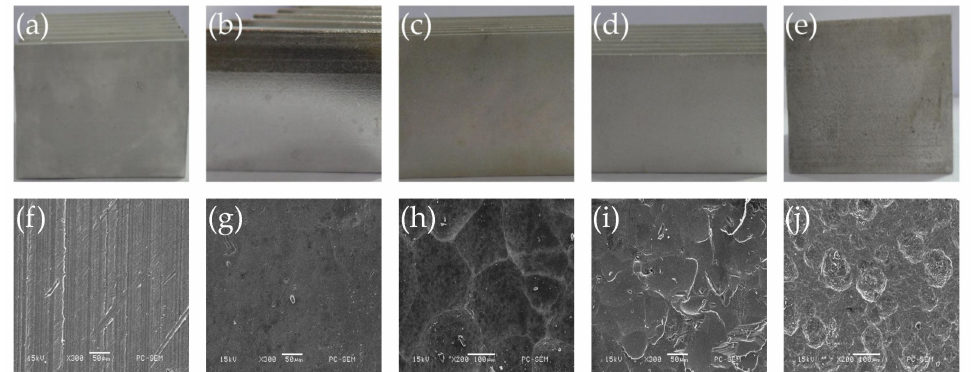
Figure 4. Surfaces of heat sinks with different treatment: photos of heat sinks ( a ) without treatment, ( b ) chemical polishing, ( c ) chemical coarsening, ( d ) mechanical shot peening and ( e ) chemical oxidation; SEM images of heat sinks surfaces ( f ) with- out treatment, ( g ) with chemical polishing, ( h ) chemical coarsening, ( i ) mechanical shot peening and ( j ) chemical